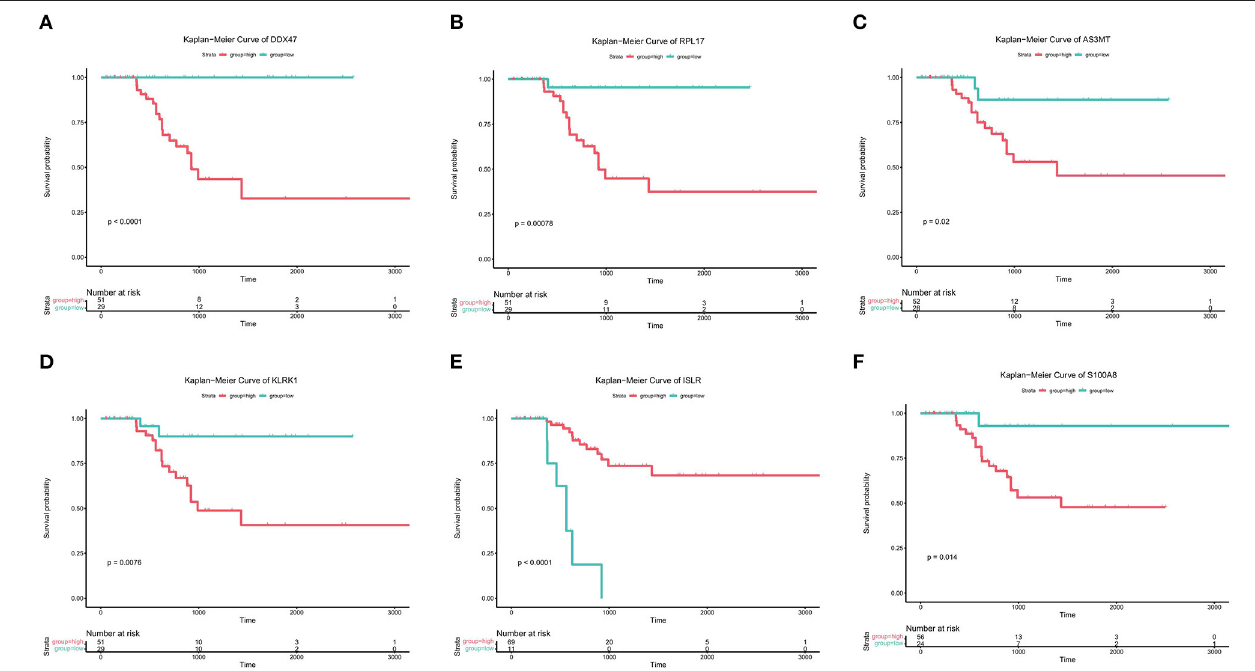
FIGURE 3 | Prognostic analysis of genes associated with bone metastases. (A-F) Kaplan-Meier analysis of the survival rates of the high- and low-expression groups of DDX47 , PRPL17 , AS3MT , KLRK1 , ISLR , and S100A8 .